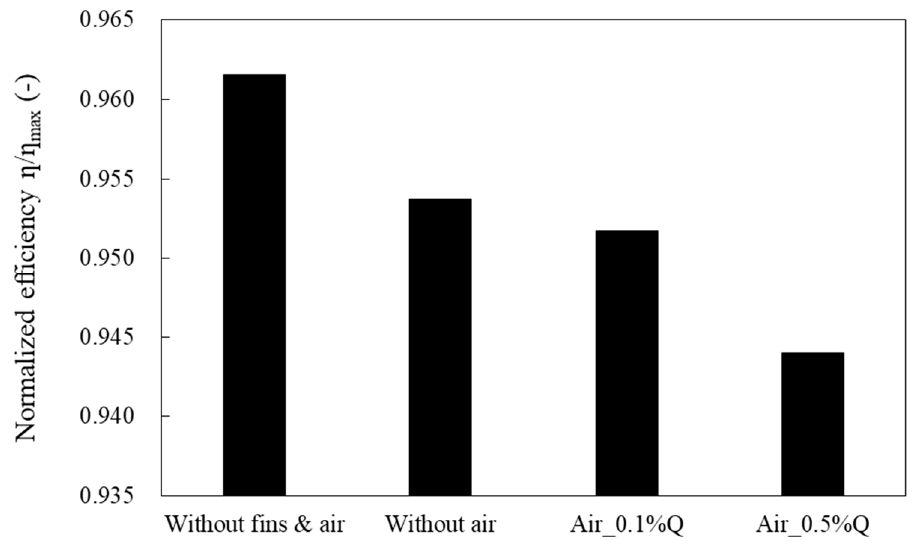
Figure 5. Comparison of efficiencies obtained with and without air injection and anti-swirl fins in the DT.